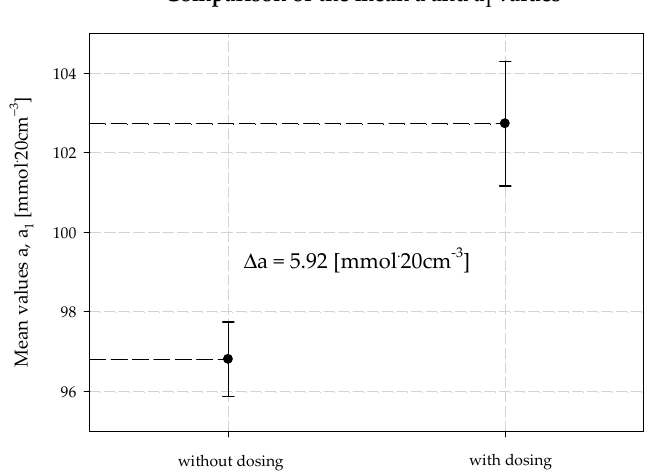
Figure 15. Total ammonium concentration values with and without dosing AAB to B10.